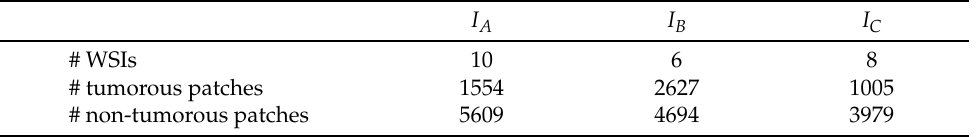
Figure 2. Examples of the type of histological patches used in this case study: ( a ) tumorous patches extracted from the annotated region made by dermatopathologists; ( b ) non-tumorous patches. Table 1. Details of the histological image data used in this use case. Note that non-tumorous patches were then randomly undersampled to balance the dataset before training each